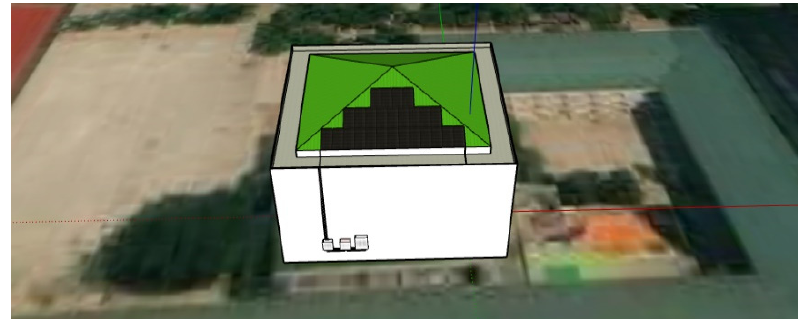
Figure 4. Rooftop solar panel layout on Sketchup 3D.